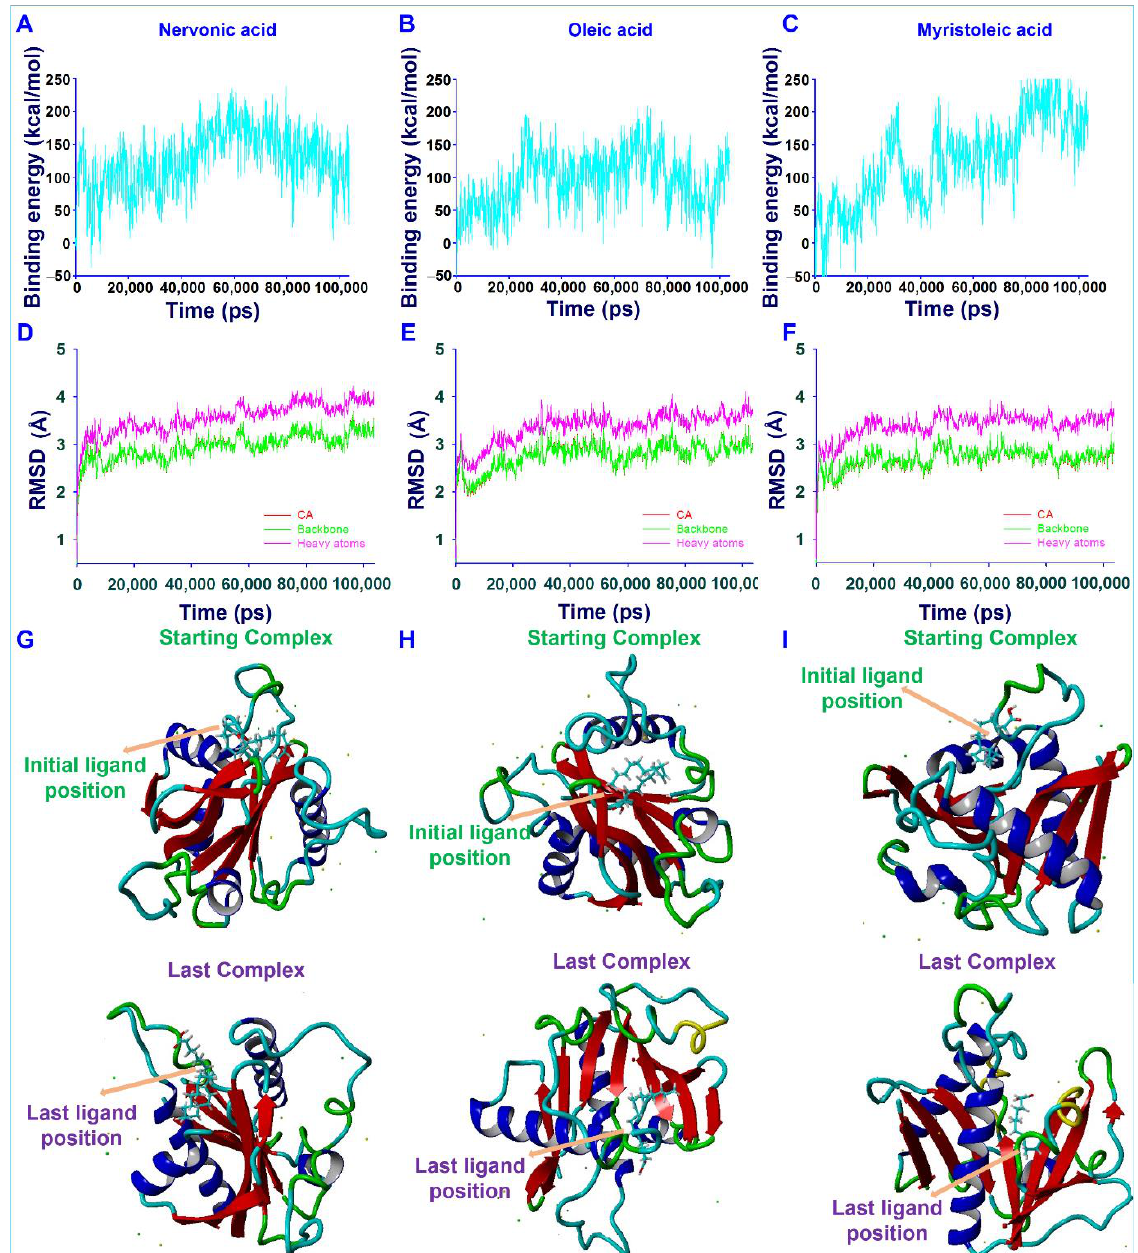
Figure 5. Ligand–AbaI complex stability studies to reveal the interactions. Binding energies ( A – C ) and RMSD of nervonic, oleic, and myristoleic acid, respectively, as determined by MD simulation of YASARA ( D – F ). Ligand–AbaI complex comparative binding positions of nervonic ( G ), oleic ( H ), and myristoleic acid ( I ) with AbaI as displayed before and after 100.3 ns MD simulations.